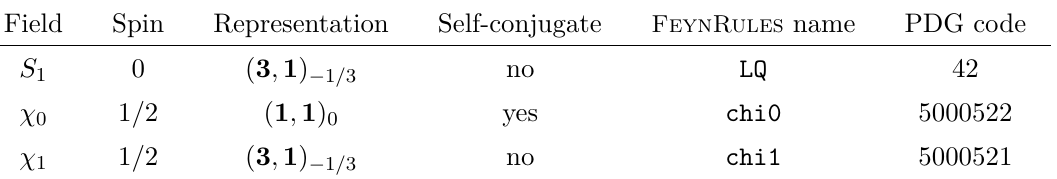
Table 5 . New particles supplementing the Standard Model, given together with their representation under SU(3) c × SU(2) L × U(1) Y . We additionally indicate whether the particles are self-conjugate, we introduce their name in the FeynRules implementation and the associated PDG identifier. As the PDG code 42 is the official PDG value for a leptoquark [100], there are no issues when running parton showering and/or hadronisation code.